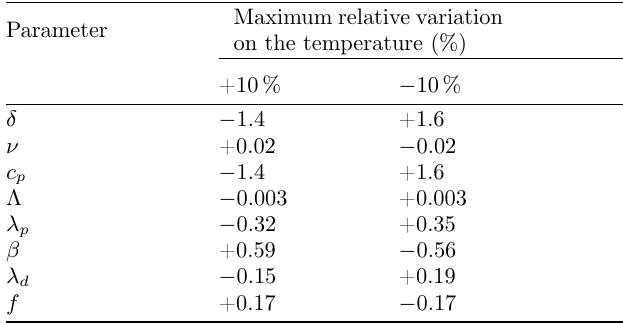
Fig. 9. Uncertainty analysis. Transients of temperature and other variables of interest, where the nominal problem solution (red line) is compared with variation of parameters of ± 10% (dash-dot lines). Table 5. Maximum relative variation of the temperature transient for a parameter shift of ± 10% from its nominal value. The center column shows temperature maximum change for an input parameter increase of 10%, while in the right column the parameter is decreased of the same